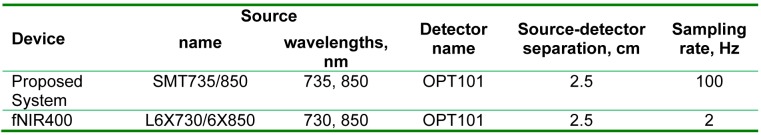
The main parameters of proposed and commercial fNIRS devices